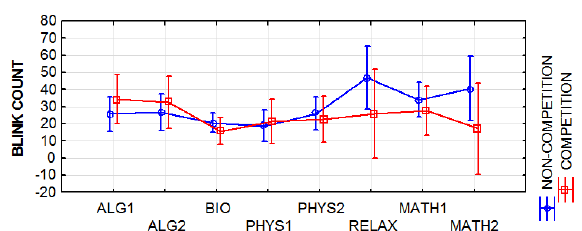
Figure 6. The blink count - a distribution of the mean values for the particular tasks and the relax